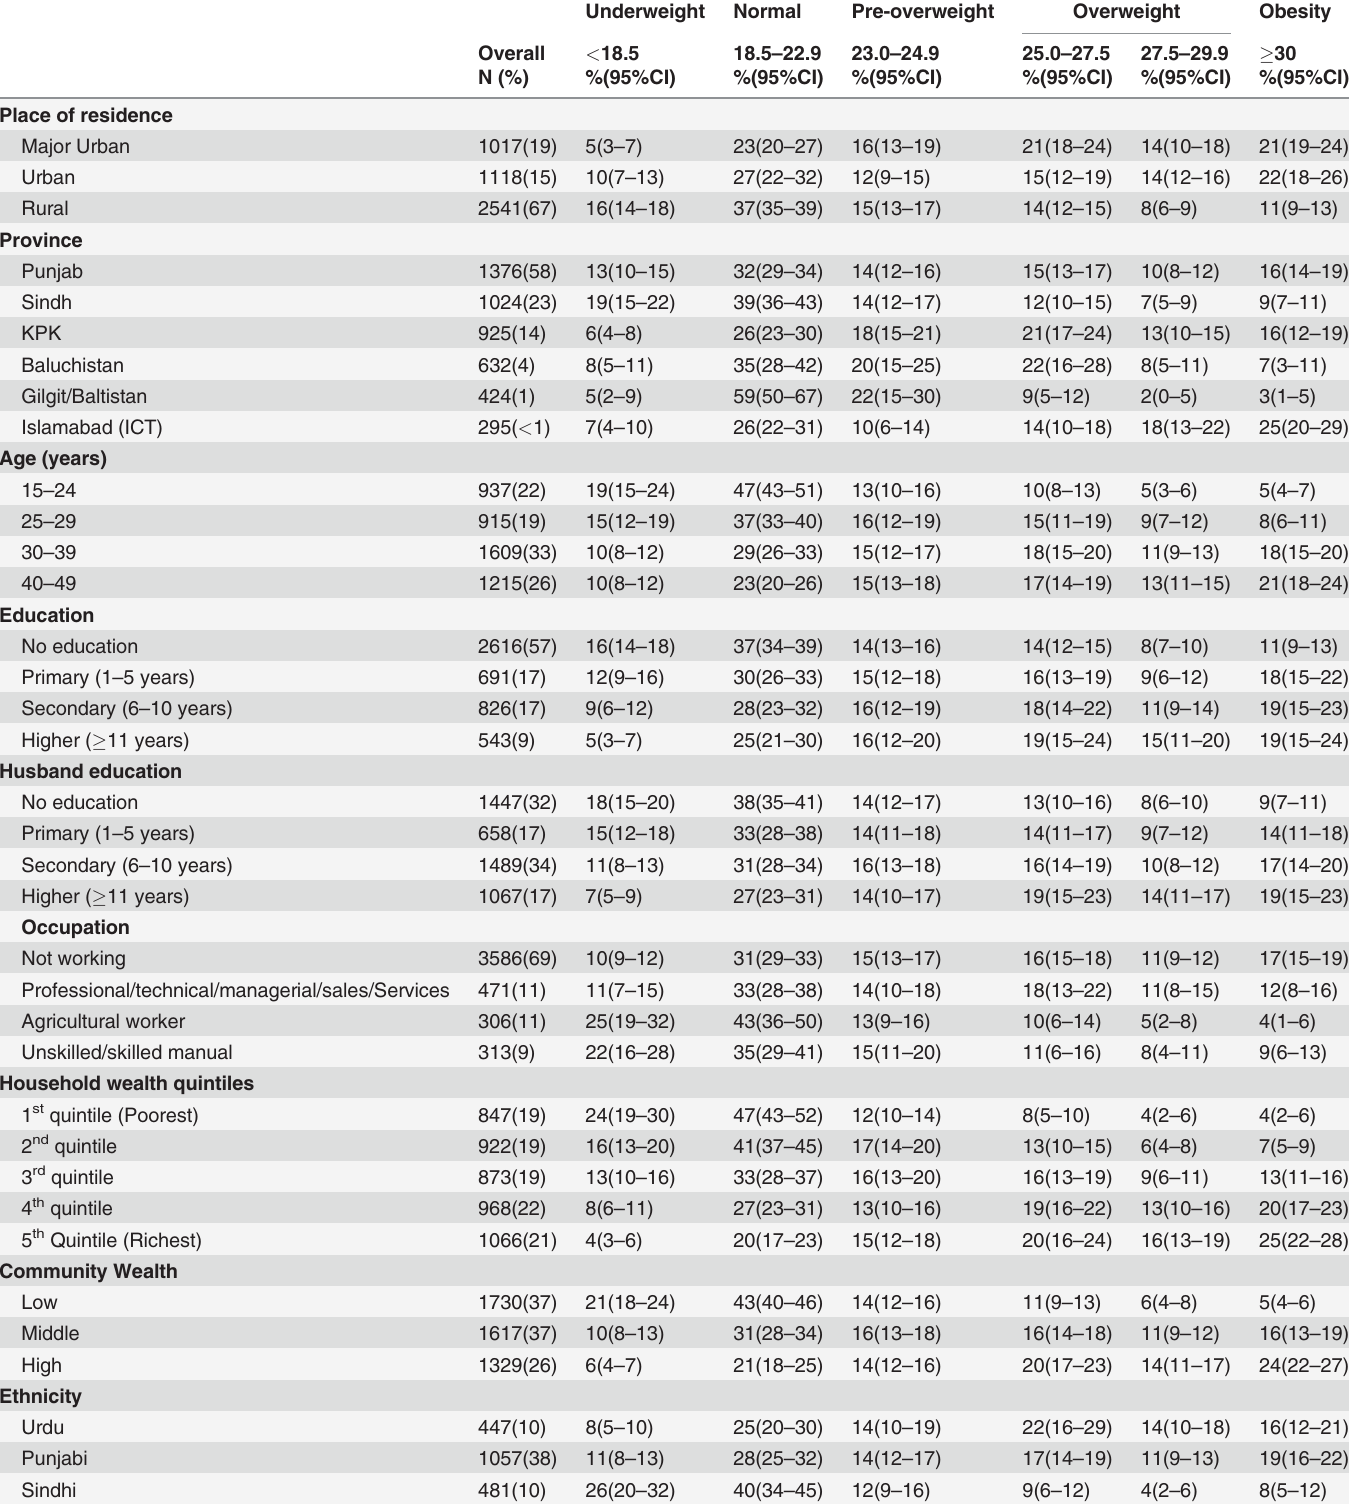
Table 1. Distribution of BMI by participants ’ characteristics, Demographic and Health Survey of Pakistan 2012 – 13. Underweight Normal Pre-overweight